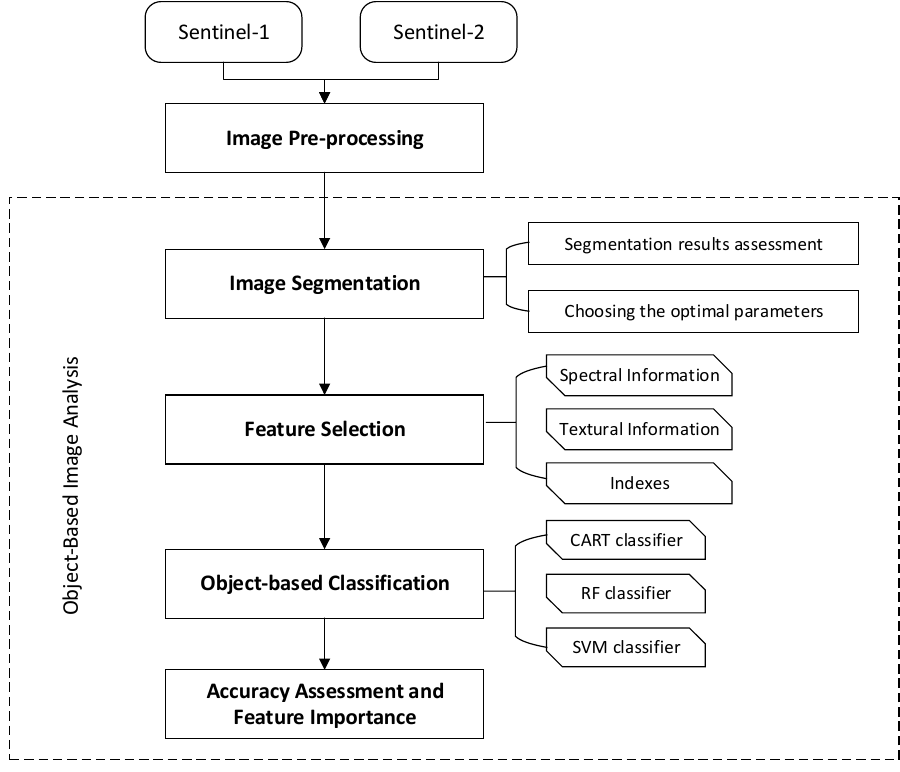
Figure 4. The workflow of the study.